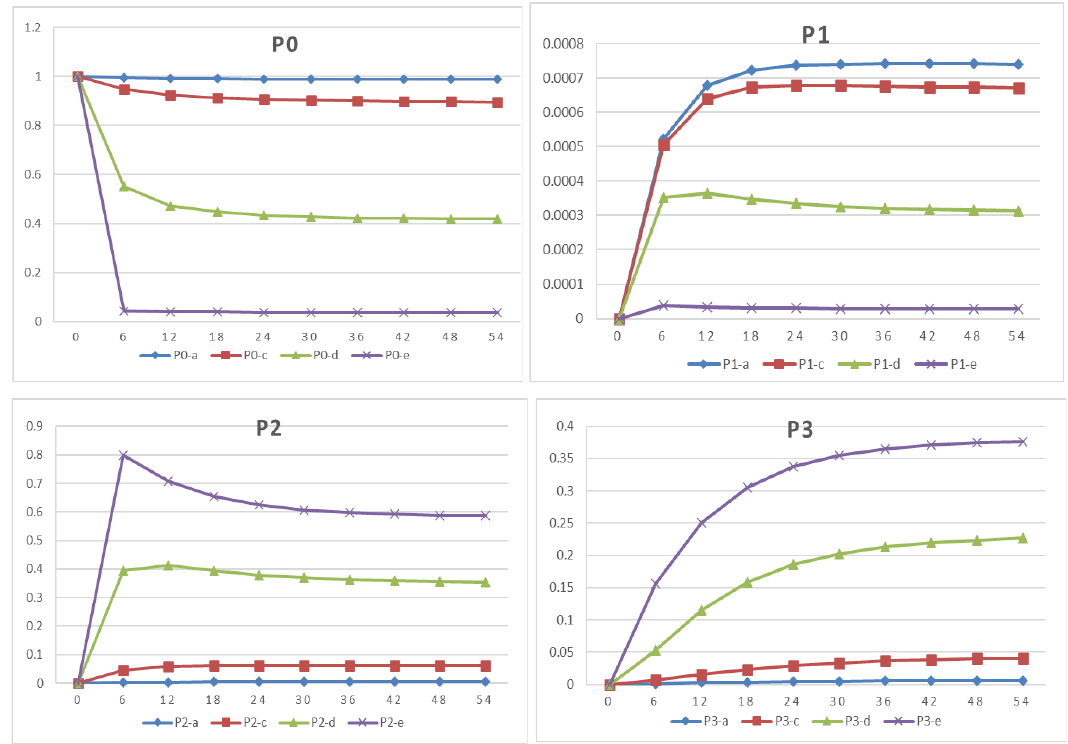
Figure 6. Probabilities of each disk state for different DDoS attack rates ρ gv ( x -axis: mission time t